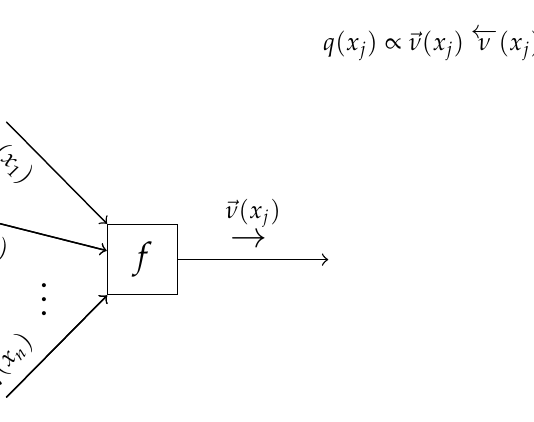
Figure 8. Example of a situational sketch of (22) where a variational message (cid:126) ν ( x j ) flows out of an arbitrary node f ( x 1 , x 2 , . . . , x n ) with marginals q ( x